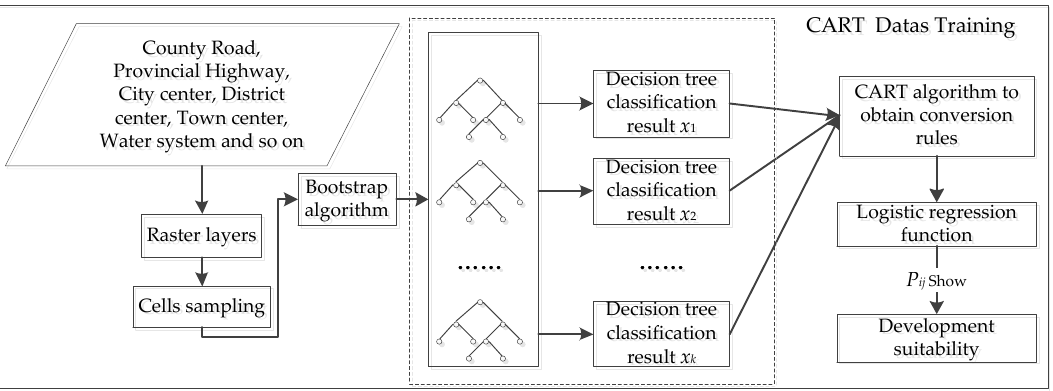
Figure 1. Classification and Regression Tree (CART) training flow chart.